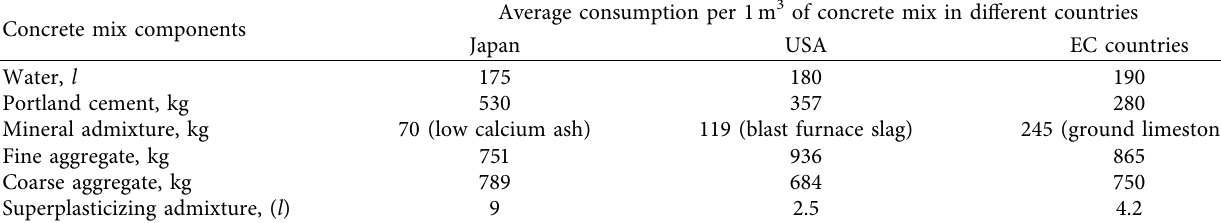
Table 1: Average compositions of self-compacting